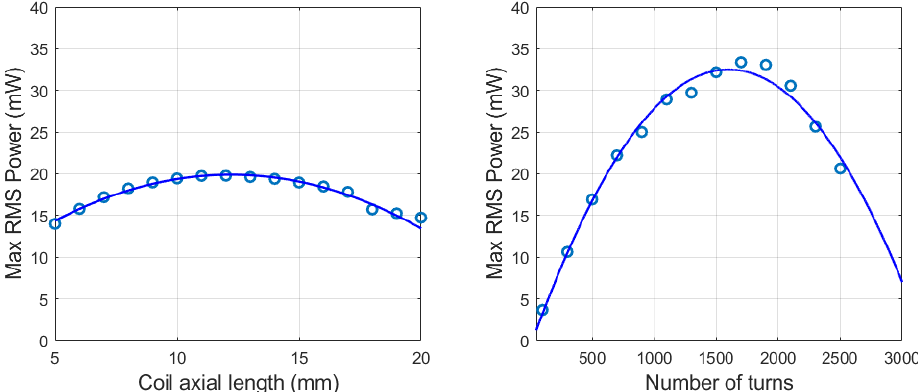
Figure 14. Coil axial length and number of turns sensitivity